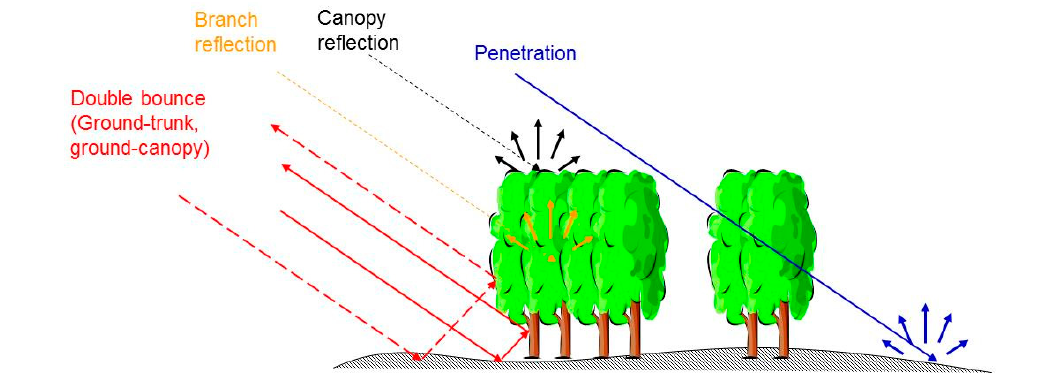
Figure 1. Backscattering from a vegetated terrain [21].